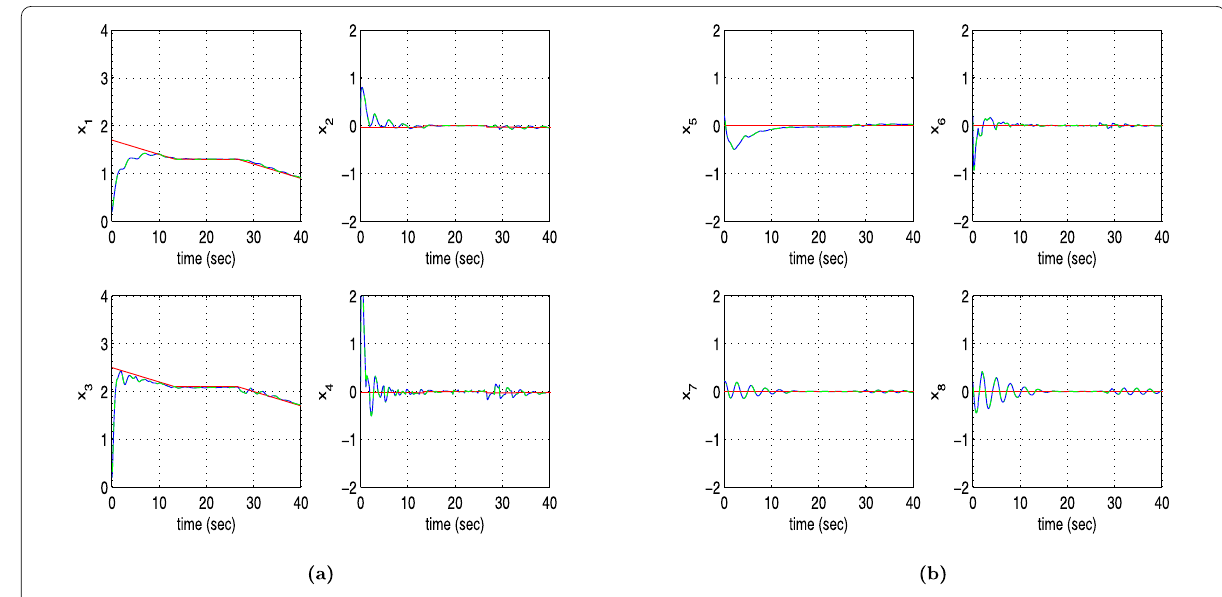
Figure 11 Tracking of setpoint 5 for the tower crane ( a ) convergence of state variables x 1 to x 4 to their reference setpoints (red line: setpoint, blue line: real value, green line: estimated value), ( b ) convergence of state variables x 5 to x 8 to their reference setpoints